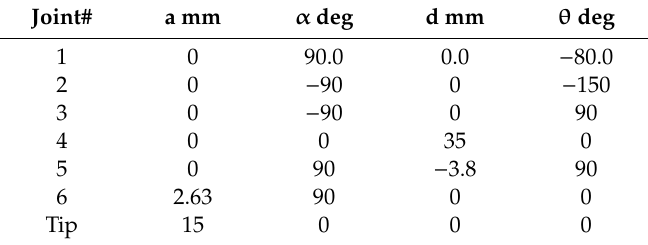
Table 5. Denavit–Hartenberg (DH) parameter of Condition (B).